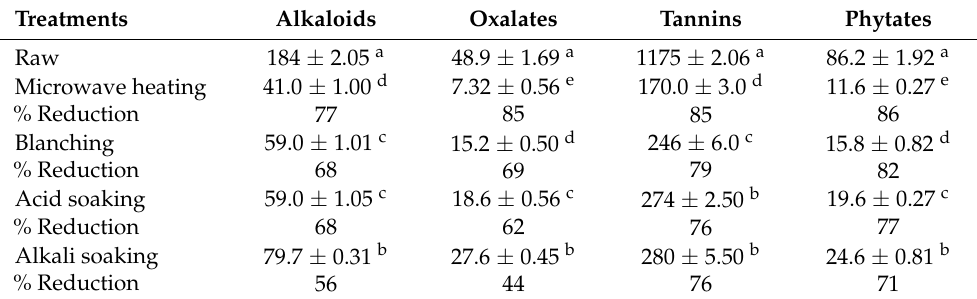
Values are means ± S.E. (n = 2). Values bearing identical lettering in each column are non-significant ( p > 0.05). % reduction is the reduction compared to the raw CP. % reduction represents the rate of reduction in antinutrients from the raw to the treated cabbage vis. microwave heated, blanched, acid or alkali soaked.